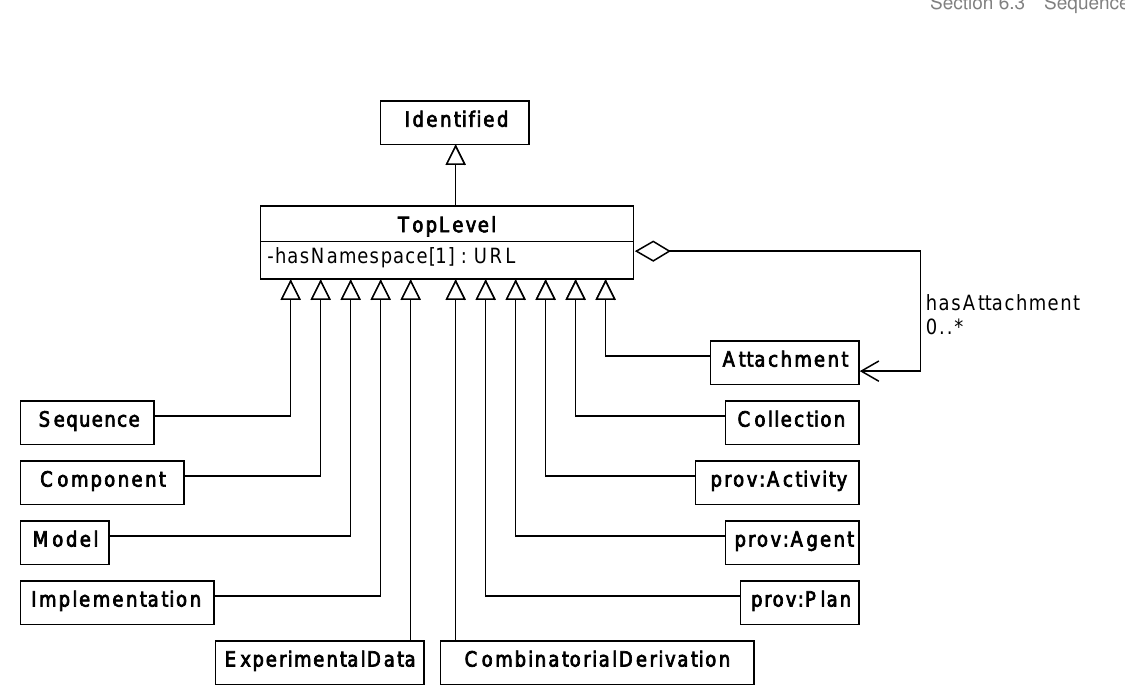
Figure 6: Classes that inherit from the TopLevel abstract class.